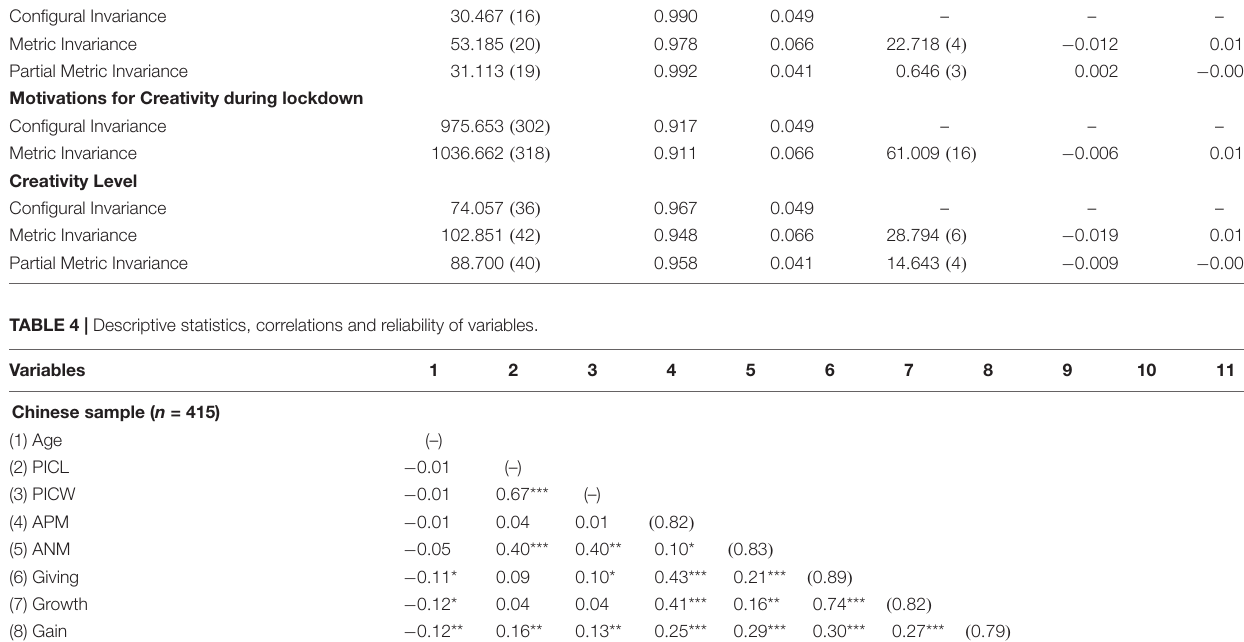
TABLE 3 | Measurement invariance test of the variables under investigation across the two countries. Model χ 2 (df)